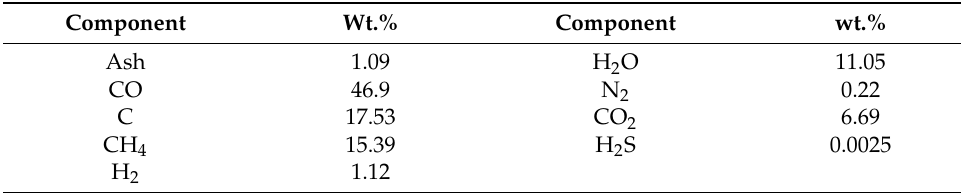
Table 5. Mass yield distribution (wt.%) from biomass